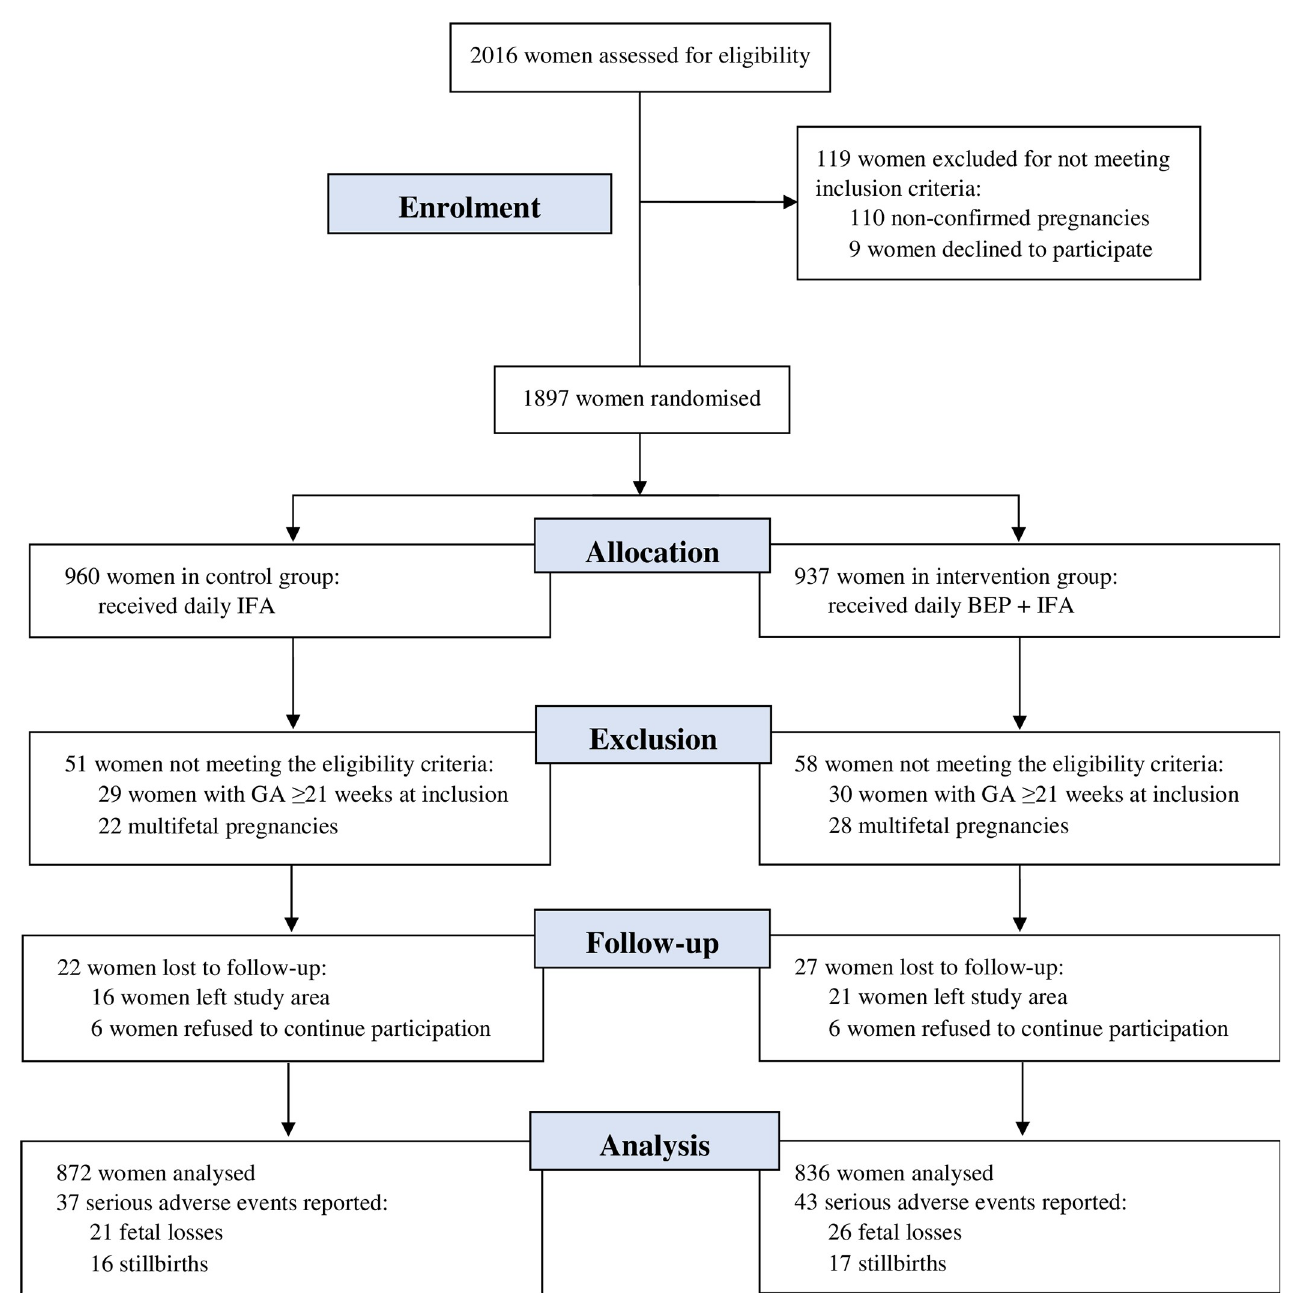
Fig 1. CONSORT flowchart. B AU : AbbreviationlistshavebeencompiledforthoseusedthroughoutFigs 1 (cid:0) 3 : Pleaseverifythatallentriesarecorrect : EP, balanced energy–protein; CONSORT, Consolidated Standards of Reporting Trials; GA, gestational age; IFA, iron–folic acid. https://doi.org/10.1371/journal.pmed.1004002.g001 BEP supplementation led to a mean 3.1 pp reduction in SGA with a 95% confidence inter- val (CI) of − 7.39 to 1.16 ( P = 0.151) (Table 4). The main finding was confirmed by adjusting the regression model for prognostic factors of SGA ( − 2.93 pp, − 7.04 to 1.17, P = 0.161), by (un)adjusted complete cases (850 control and 809 intervention) analyses ( − 3.15 pp, − 7.41 to 1.12, P = 0.148; S1 Table), and by (un)adjusted per protocol (850 control and 631 intervention) analyses ( − 3.30 pp, − 7.89 to 1.29, P = 0.160; S2 Table).